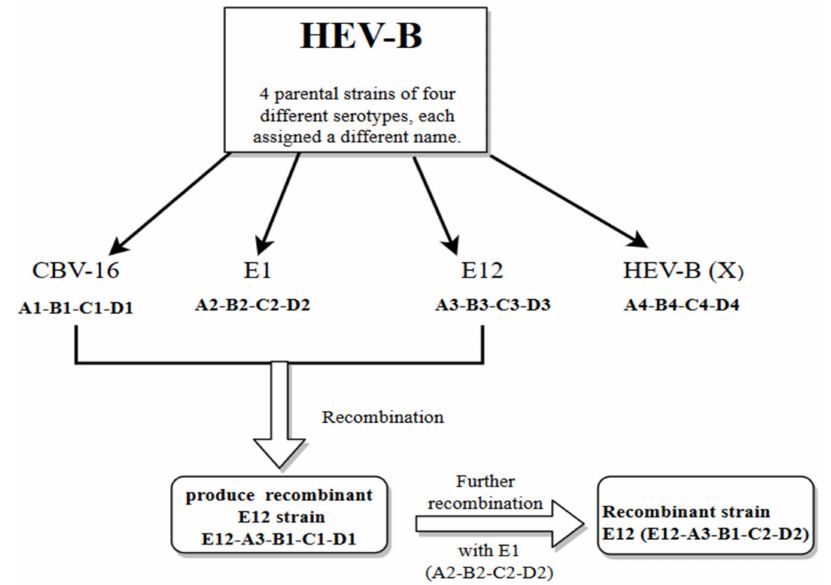
Figure 2. Illustration showing the two events of recombination of HEV-B (CBV16, E1, E12 and X) using similarity plots. CBV-16, E12, E1 and X refer to the designated names of four ancestral strains of four different serotypes. The white arrows indicate the recombination events between the two ancestral strains (CBV-16 and E12) and further recombination with